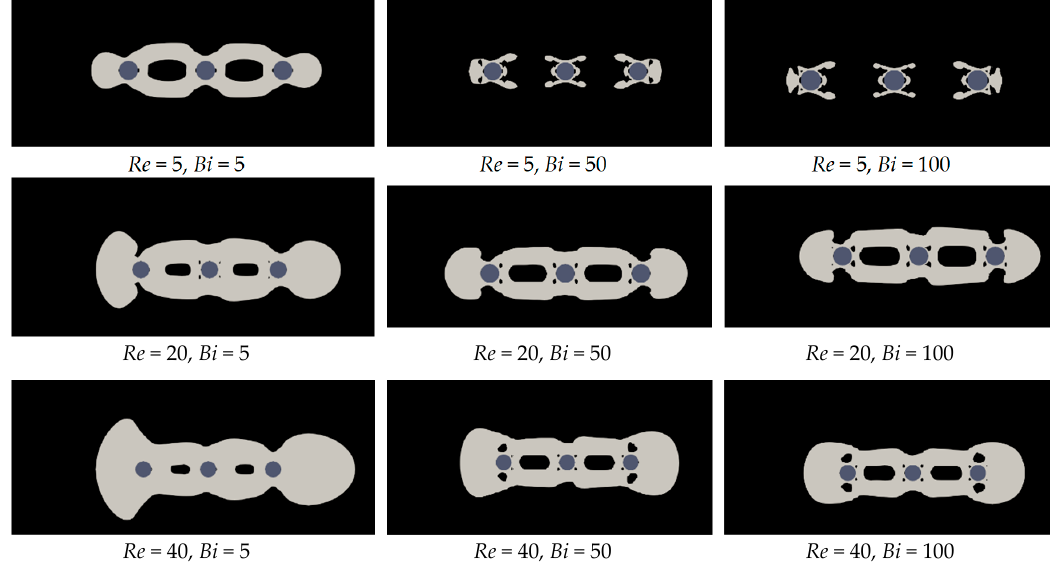
Figure 9. Progressive growth of the unyielded region (shaded) with the increasing Bingham number and decreasing Reynolds number where d = 4.0 D.